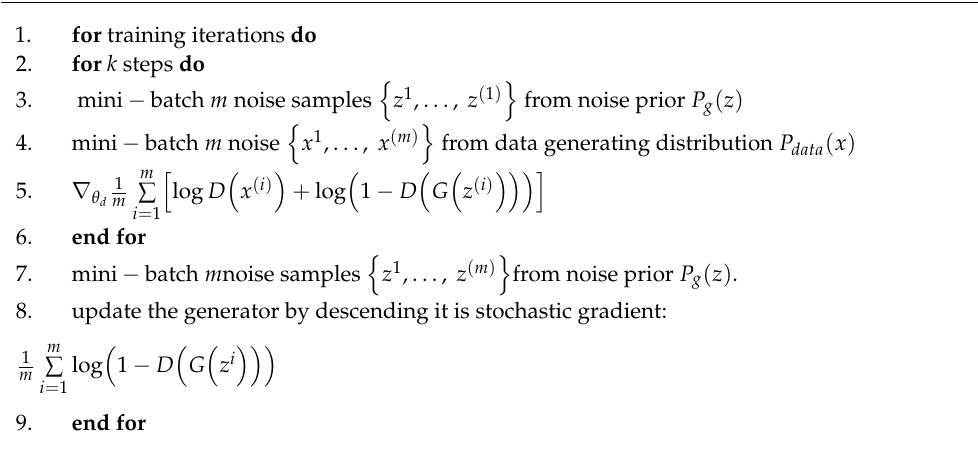
Algorithm 2 A summary implementation of the generative adversarial nets proposed in 2014